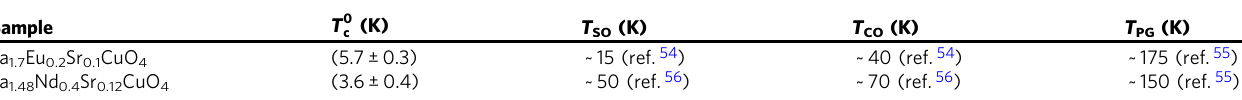
Table 1 Characteristic temperatures.